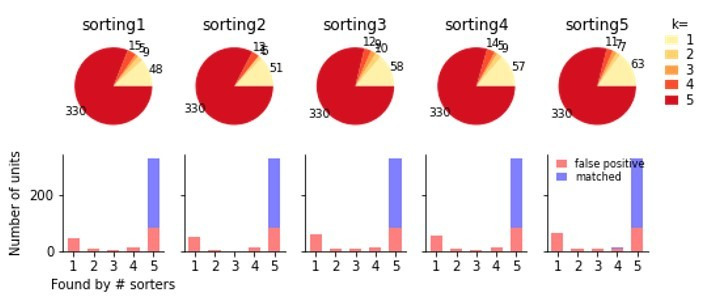
Comparison of five individual runs of Kilosort2 on the simulated Neuropixels recording.The top shows the proportions of units from each sorting found in k other sortings. Below these units are split according to false and true positive units after comparison to the ground-truth data. While a sizable fraction of false positive units are unique to each run of the sorter, many are identical in all sortings, indicating that variability in multiple sorter outputs cannot be used to reliably separate false and true positive units.